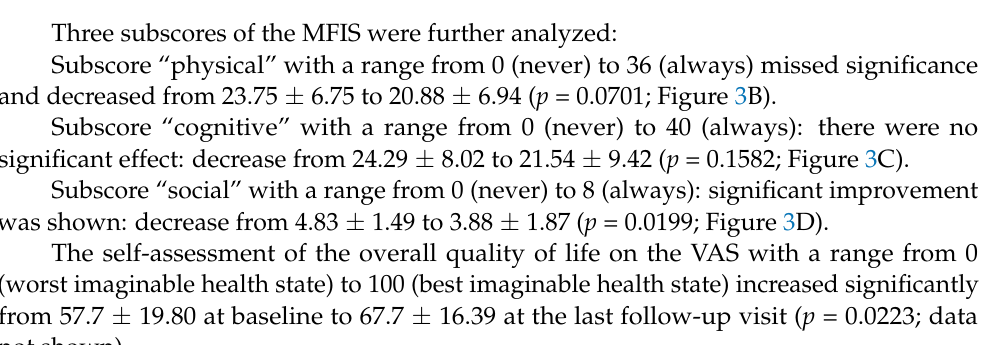
Figure 3. Modified Fatigue Impact Scale (MFIS) at baseline and last follow-up visit. ( A ) MFIS, range from zero (never) to 84 (always); ( B ) MFIS subscore “physical”, range from zero (never) to 36 (always); ( C ) MFIS subscore “cognitive”, range from zero (never) to 40 (always): ( D ) MFIS subscore “social”, range from zero (never) to 8 (always). Results are shown as mean (“+”), median (“ ― “), and standard errors.